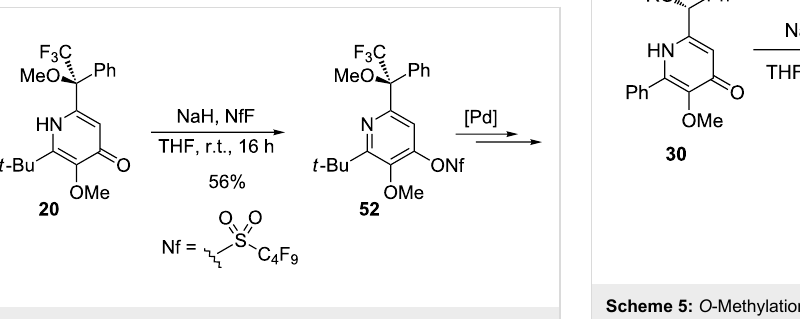
Scheme 4: Synthesis of pyrid-4-yl nonaflate 52